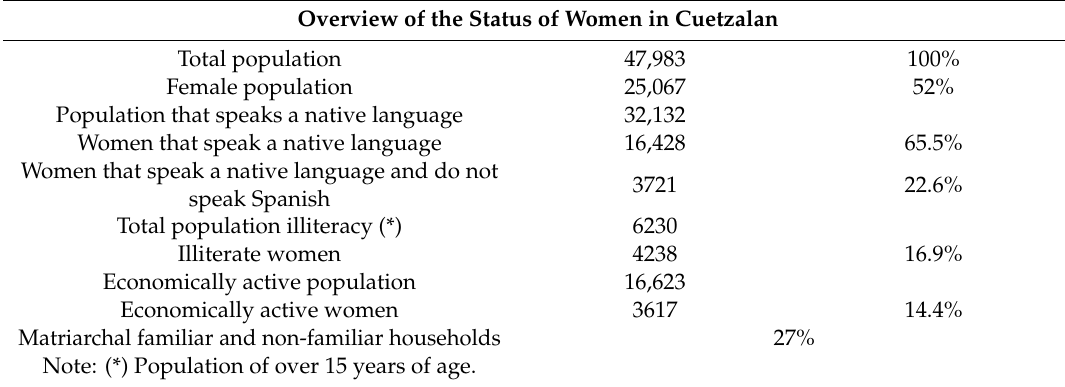
Table 1. Overview of the status of women in Cuetzalan. Source: Adapted from SNIM (Sistema